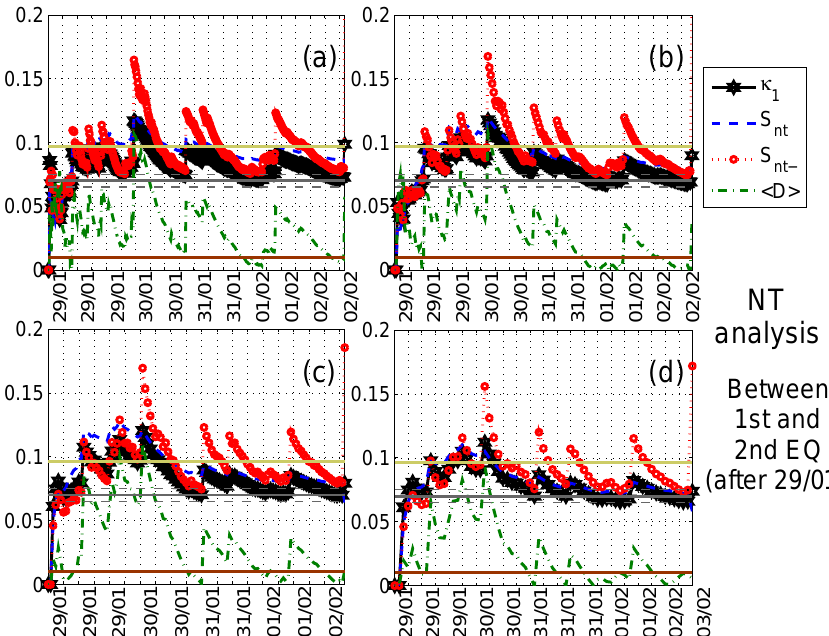
Figure 12. Natural time (NT) analysis results for the seismicity in the partition of western Cephalonia during the time period from 29 Jan- uary 2014 00:00:00 to 03 February 2014 03:08:47UT (between EQ1, M w = 6 . 0, and EQ2, M w = 5 . 9 ) : (a–d) temporal evolutions of the four natural time analysis parameters ( κ 1 , S nt , S nt- , and (cid:104) D (cid:105) ) for the different M L thresholds 2.2, 2.6, 2.8, and 3.0, respectively. Note that the events employed depend on the considered threshold. Moreover, the time ( x ) axis is not linear in terms of the conventional date of occurrence of the events, since the employed events appear equally spaced relative to the x axis, as the natural time representation demands, although they are not equally spaced in conventional time. The horizontal solid light green, solid grey, and grey dashed lines denote the same quantities as in Fig. 6, while the horizontal solid brown line denotes the 10 − 2 limit for (cid:104) D (cid:105) . (For interpretation of the references to colours, the reader is referred to the online version of this